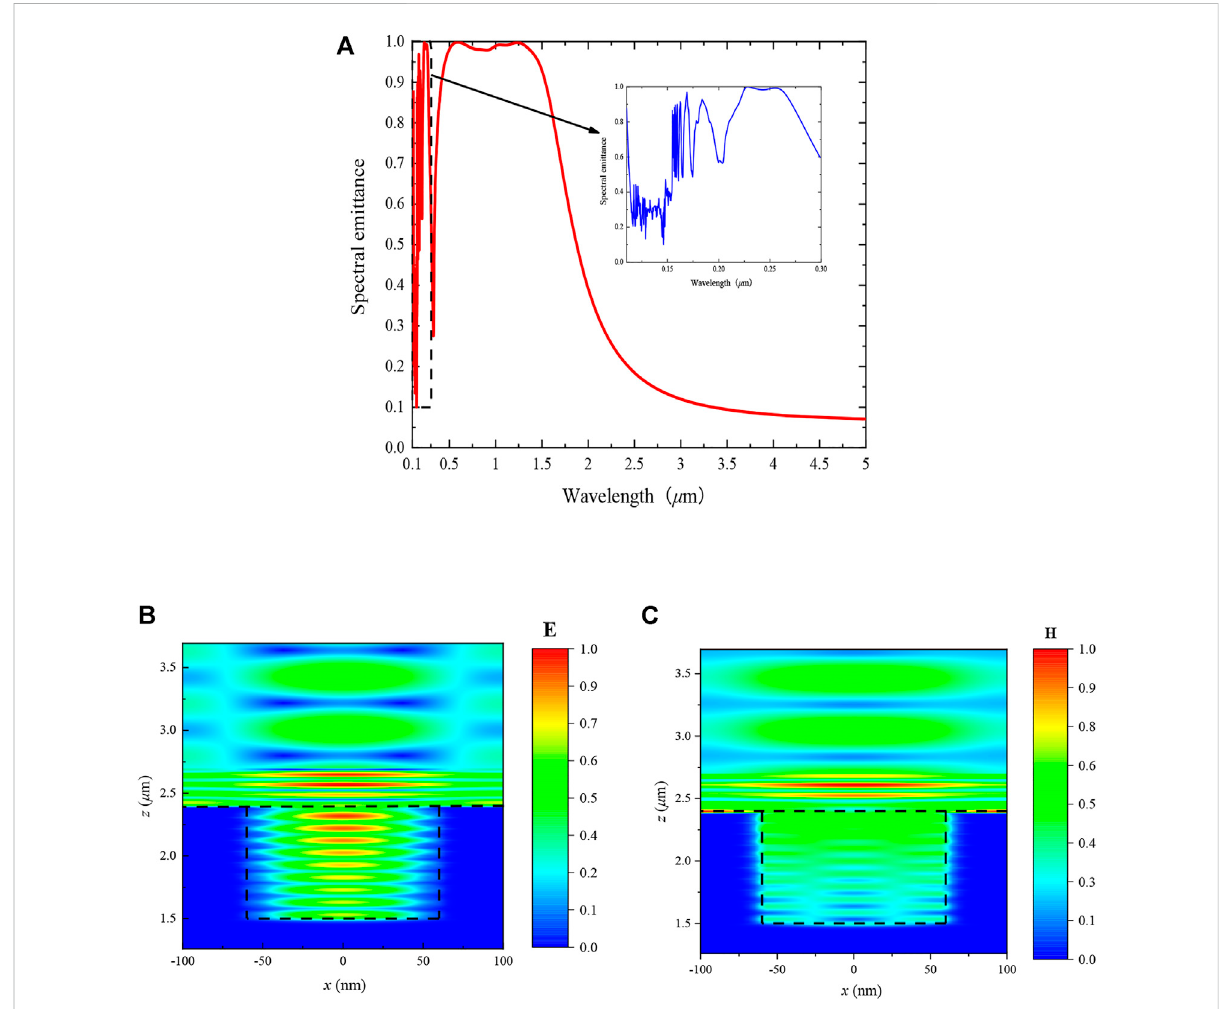
Figure 4A. The strong electric fi eld con fi nement in the array cavity with multiple standing waves can also be seen in the normalized electromagnetic fi eldmapinFigures4B,C,whichisconsistentwiththe appearance of CRs in the literature (Ye et al., 2015), indicating that the coupling mode theory is still applicable for the composite structure, which resonates with the appearance of